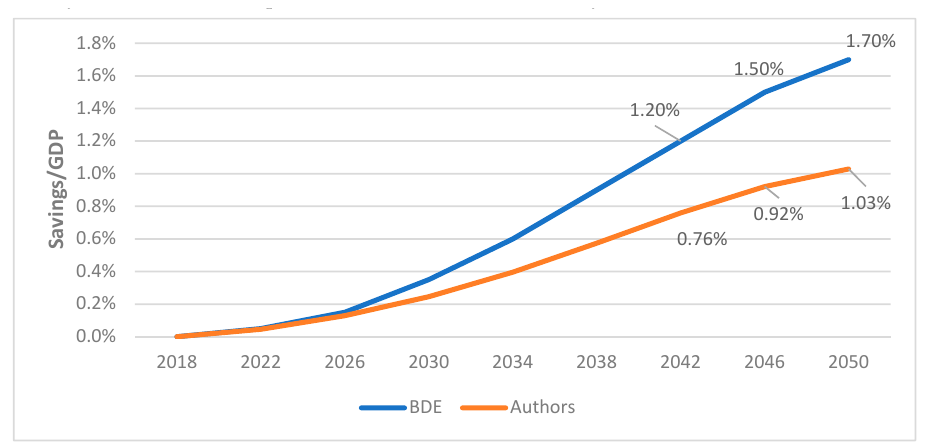
Figure 6. Annual savings / GDP applying the SF. BDE and Authors. Source: Hernandez de Cos